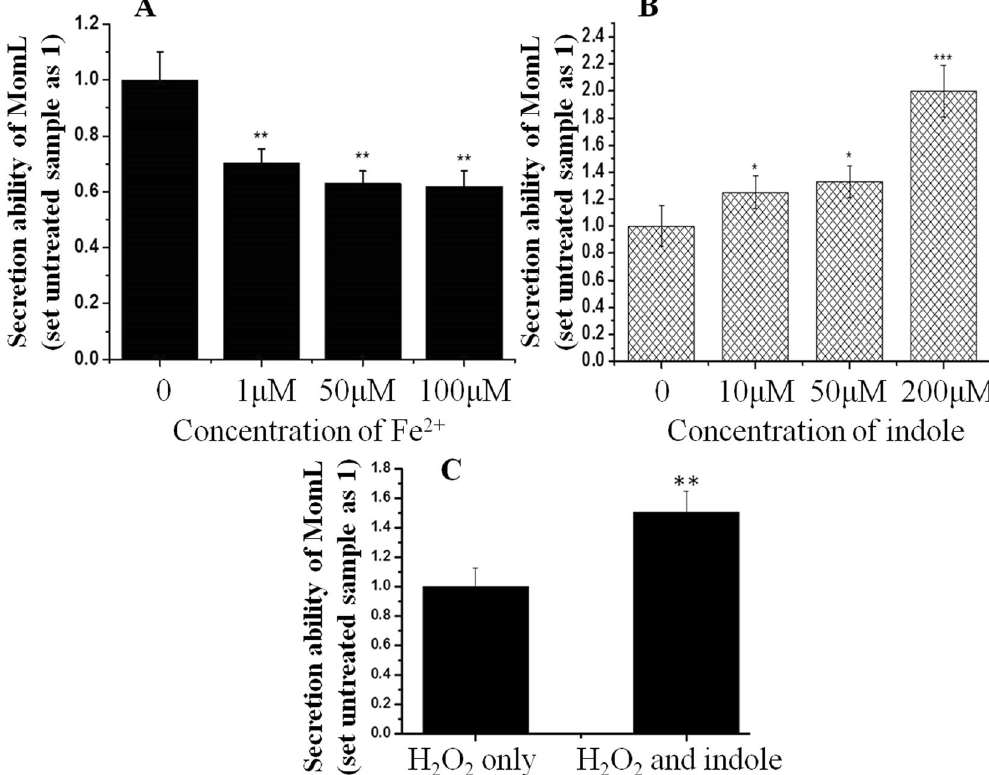
Figure 3. MomL secretion capacity analysis. ( A ) The secretion capacity of MomL in different iron environments. ( B ) Indole’s function for the MomL secretion capacity in iron deficient condition. ( C ) Indole’s function for the MomL secretion capacity in H 2 O 2